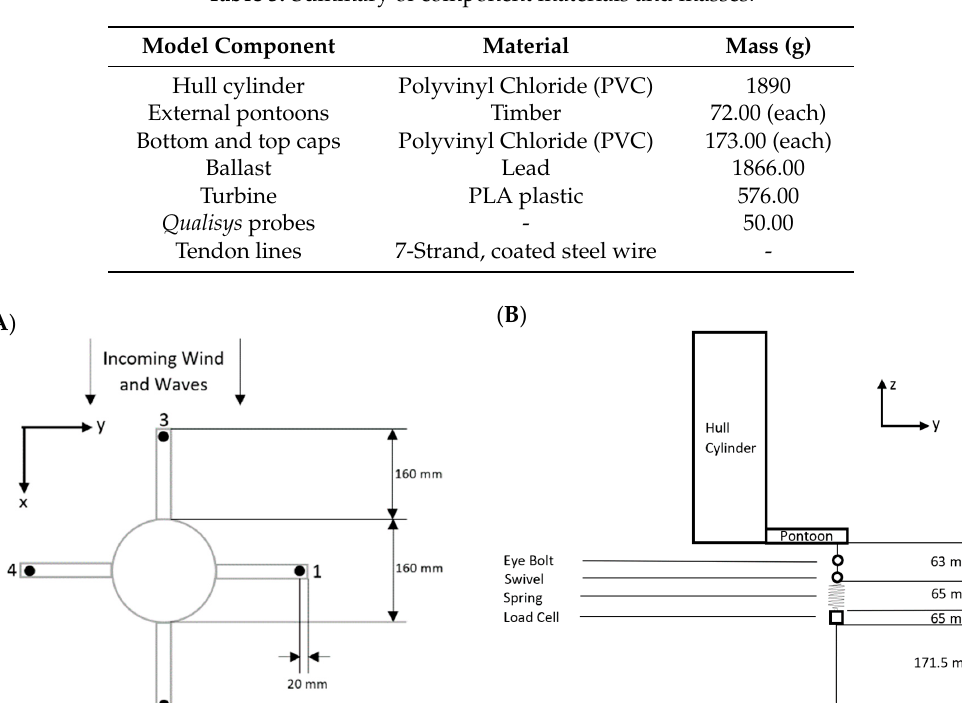
Table 3. Summary of component materials and masses.